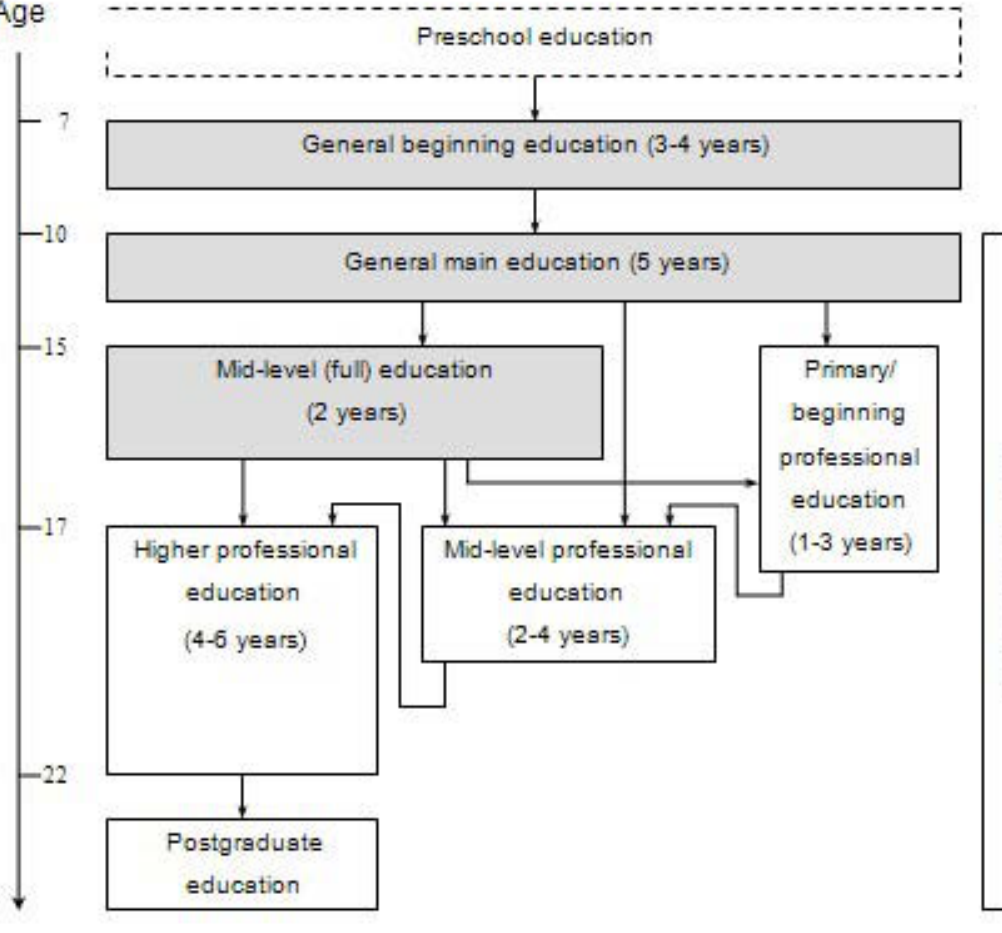
Figure 2 . Structure of the Russian higher education